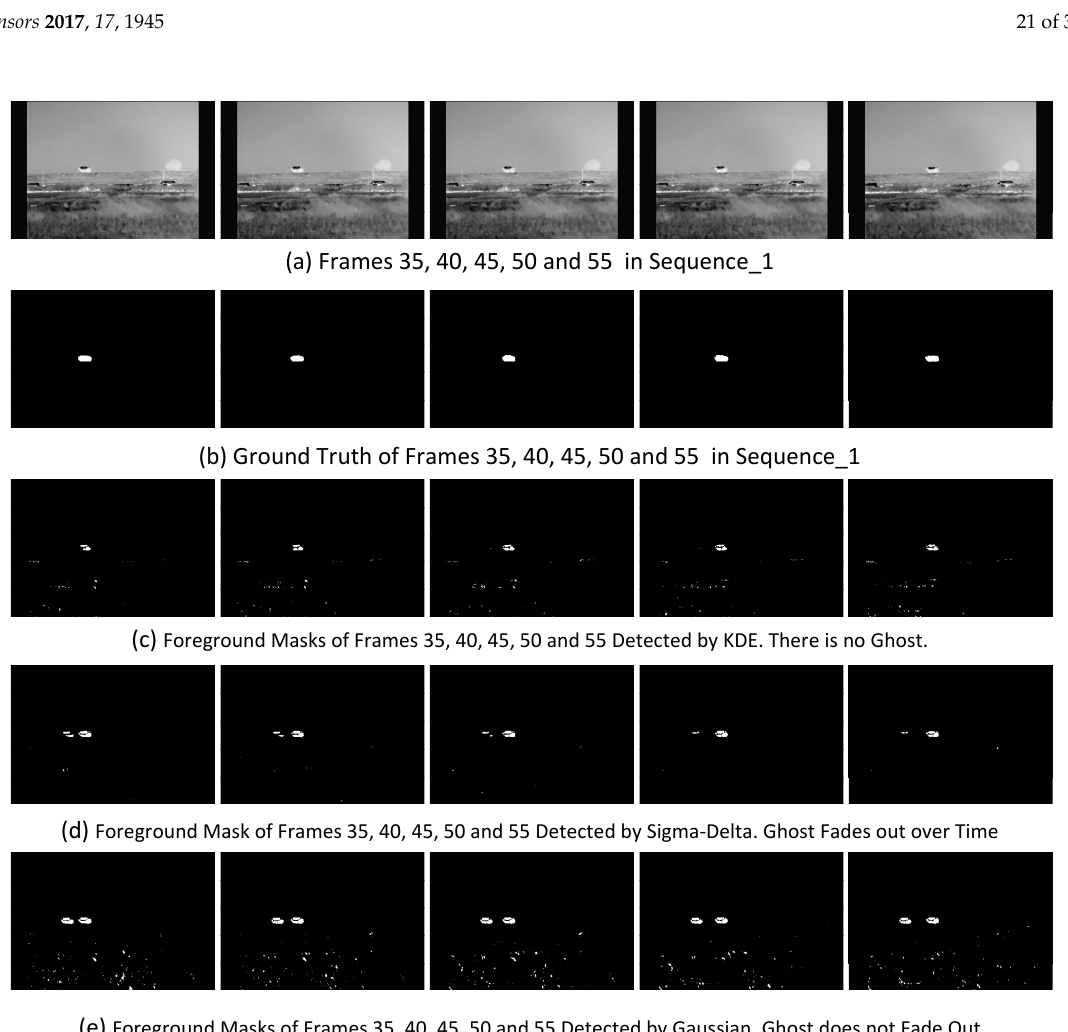
Figure 12. Comparison of the ghosts detected by different BS algorithms. Figure 13. Comparison of the ghosts detected by different BS